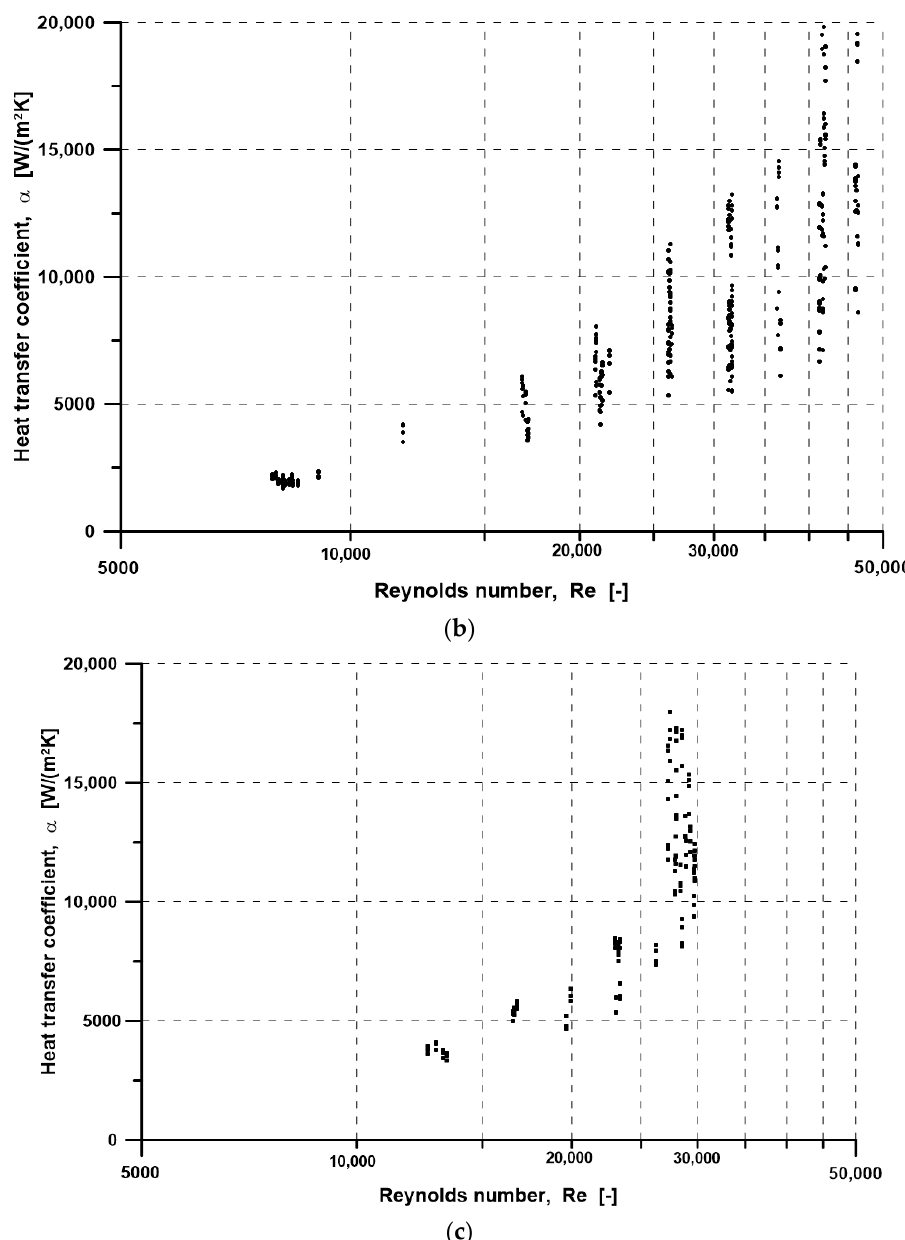
Figure 4. Heat transfer coefficient experimental values: ( a ) heater power—6 kW; ( b ) heater power—7 kW; ( c ) heater power—8 kW.